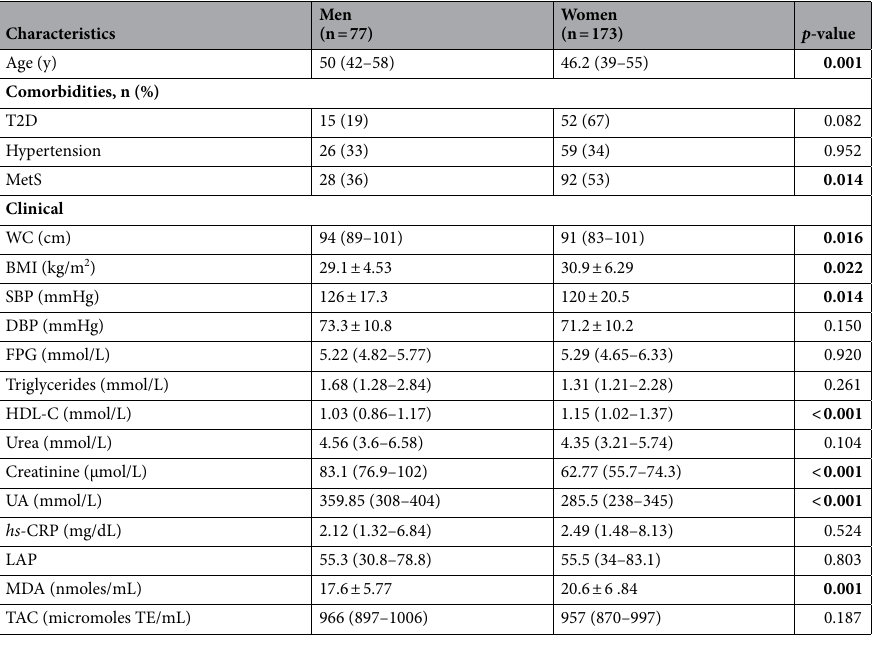
Table 1. Baseline demographic, comorbidities and clinical characteristics among men (n = 77) and women (n = 173). Data is presented using mean ± standard deviation or median (Interquartile range). Differences between groups were evaluated with independent t-test or Mann–Whitney test. p-value less than 0.05 was considered statistically significant. T2D: type 2 diabetes; MetS: metabolic syndrome; WC: waist circumference; SBP: systolic blood pressure; DBP: diastolic blood pressure; FPG: fasting plasma glucose; HDL-C: high density lipoprotein cholesterol; UA: acid uric; hs -CRP: high-sensitive C-reactive protein, LAP: lipid product accumulation; MDA: malondialdehyde; TAC: total antioxidant